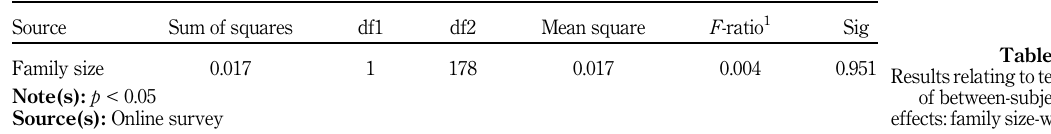
Table 7. Resultsrelatingtotests